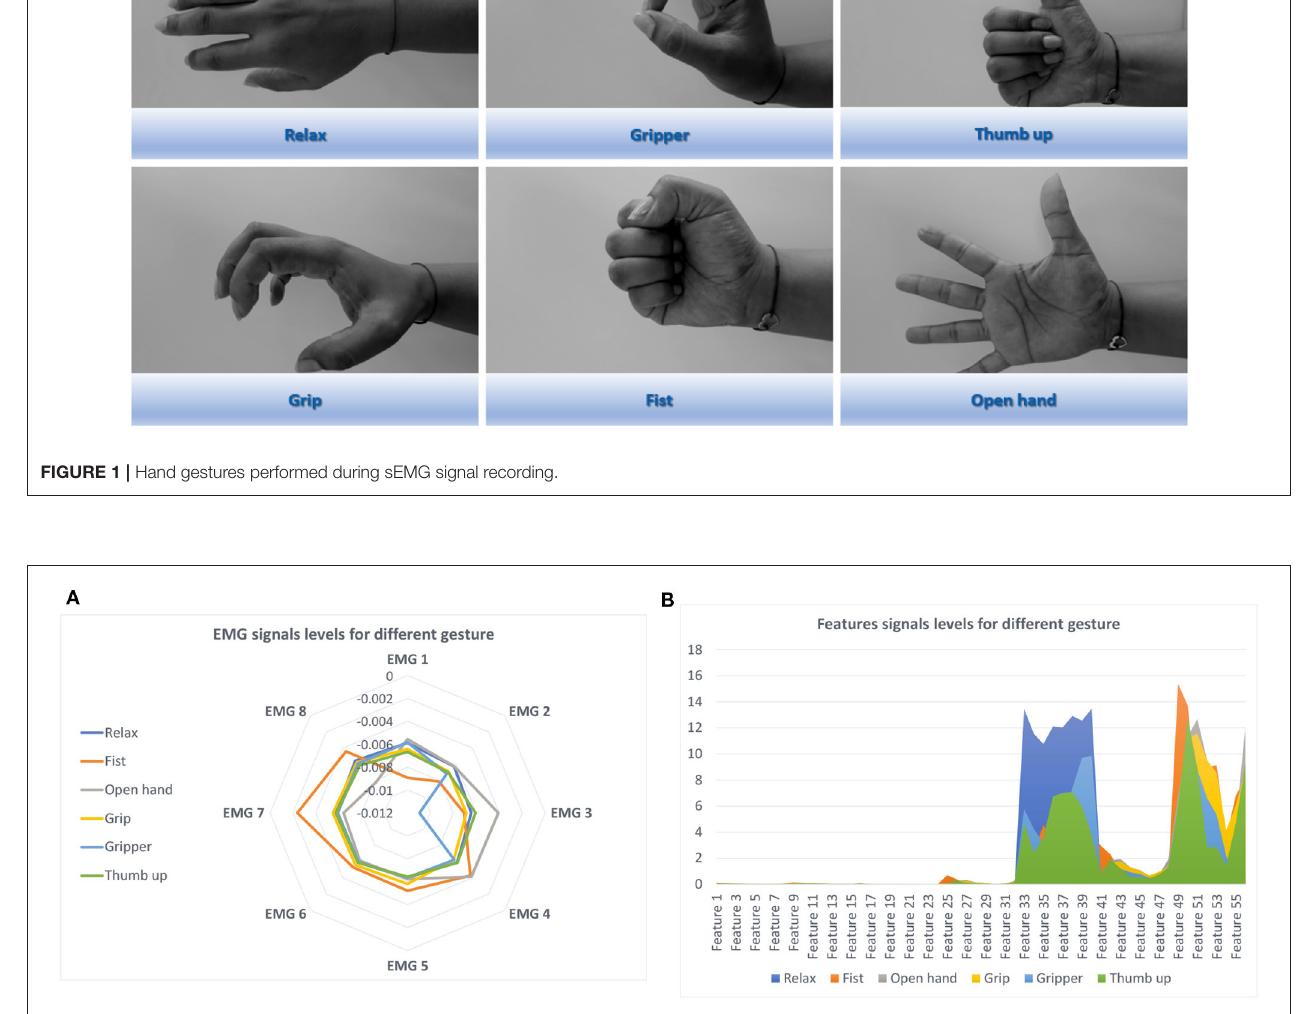
FIGURE 2 | Gesture according with the sEMG signal and features: (A) sEMG signals; (B) signals